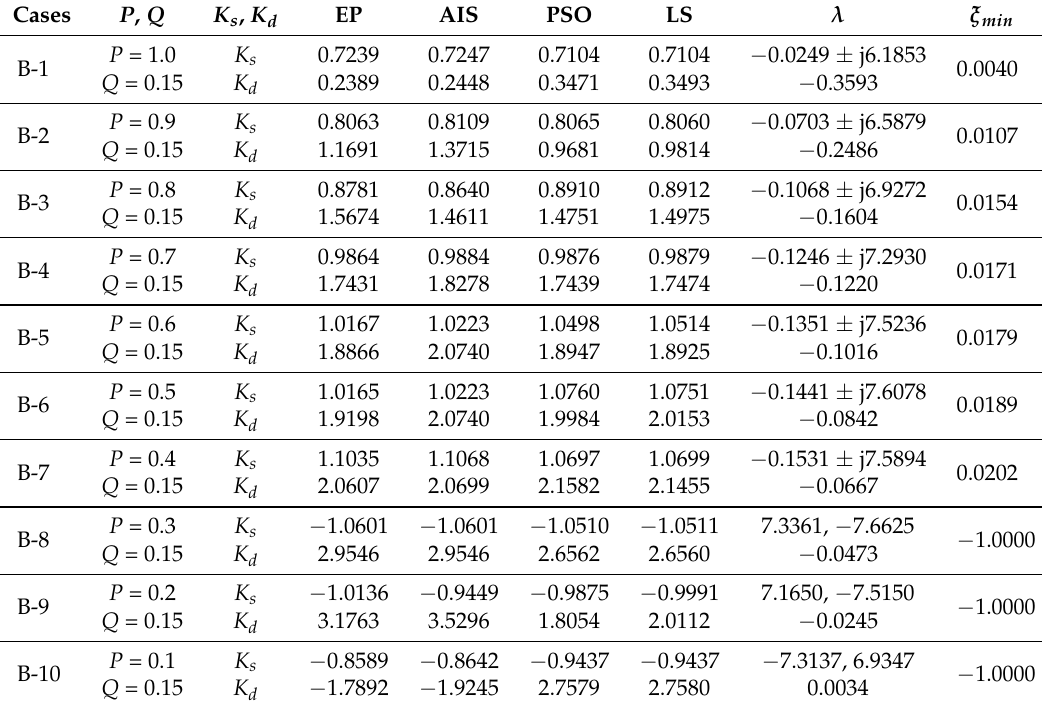
Table 4. K s and K d via EP, AIS, PSO, LS, eigenvalues and ξ min for Event